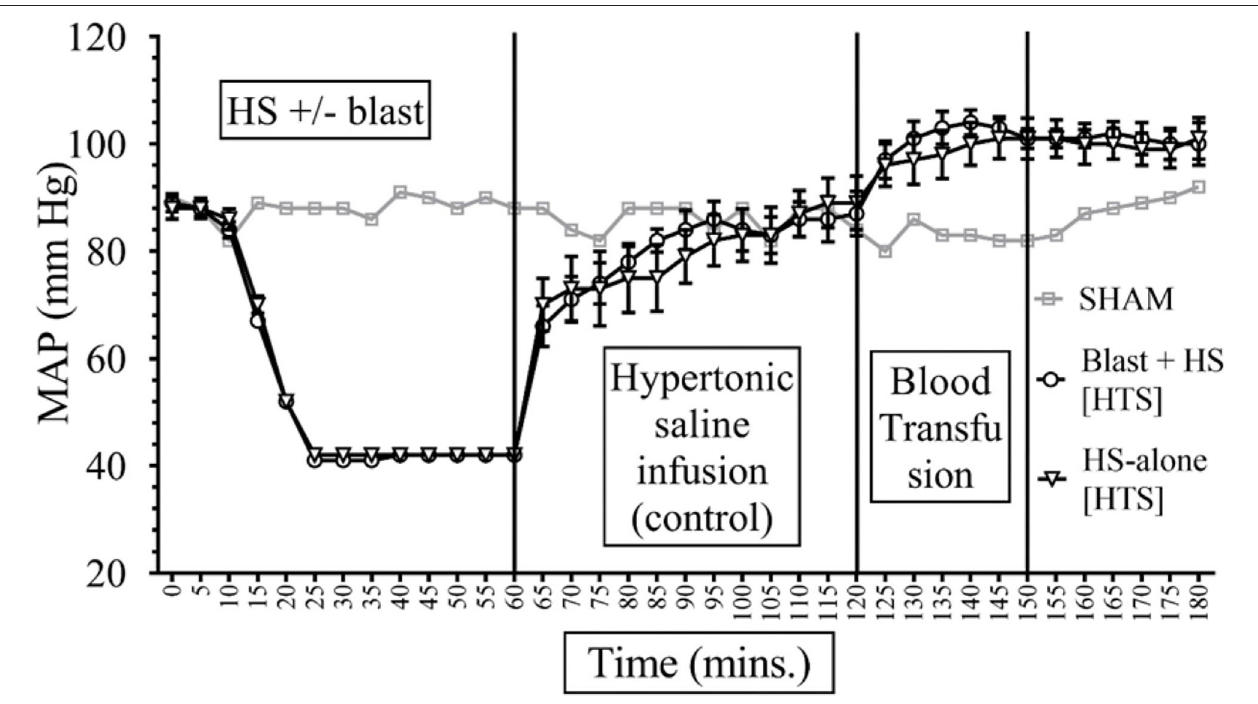
FIGURE 2 | Comparison of Mean Arterial Pressure (MAP) in Mean ± SE between the injury groups of Hypertonic Saline (7.5% saline) infusion ( n = 8). Assuming that sham represents the normal MAP values for an anesthetized rodent. All rodents had similar MAP during the baseline and HS periods of the experiments. During the HS, the MAP was maintained within 40s as intended. Intravenous fluid (IVF) infusion of HTS increased MAP toward the